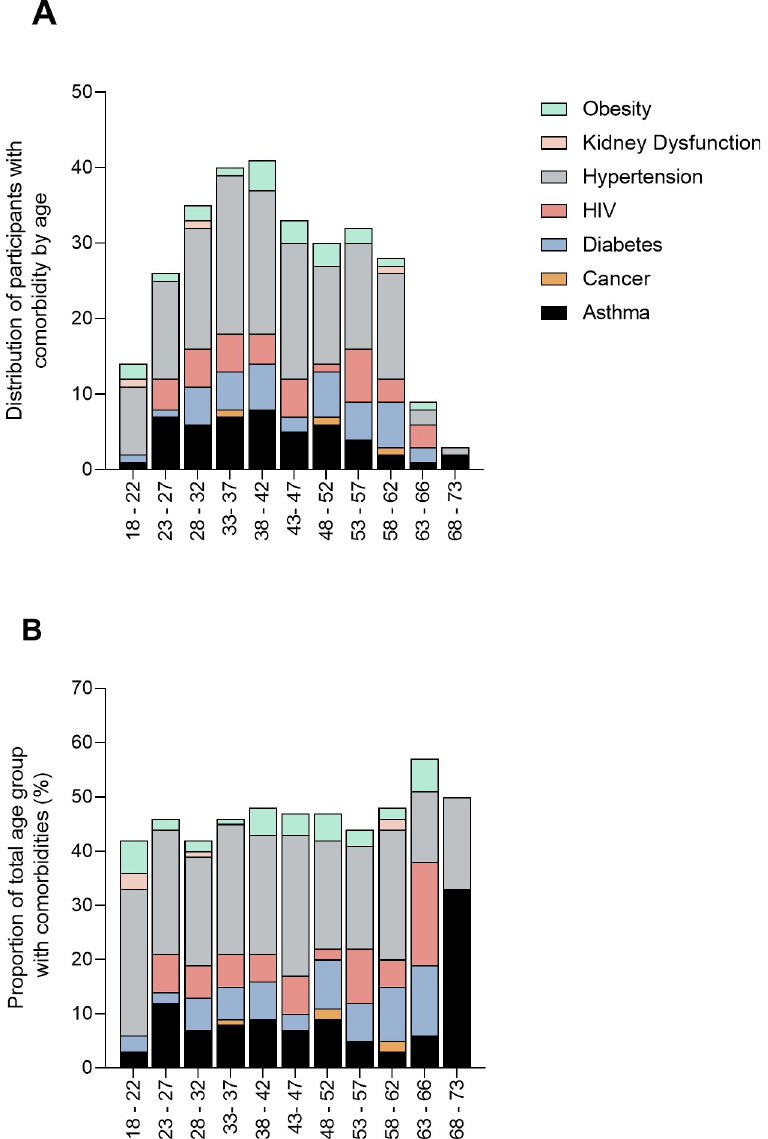
Fig 4. Distribution of the participants partitioned by age and reported co-morbidities as absolute numbers (A) and percentages (B). Of these seropositive people 15.8% (9 people) reported previous contact with a confirmed COVID-19 case. The distribution of the seropositive people by occupation, work station, age and self-reported comorbidities shown in Fig 5. The ward and OPD work stations had a great- est number of seropositive people. Odds ratios indicated that few factors were associated with sero-positivity (Fig 6) (data in Supplementary Tables, S2–S4 Tables). The odds ratios calcula- tions indicated that seropositivity was associated with working in OPD (OR 2.3, 95% CI = 1.23–4.28), aged 63–66 (OR 4.96, 95% CI = 1.66–14.81), years old and having kidney dys- function as a comorbidity (OR = 20.98, 95% CI = 1.87–235.1).The sample sizes of the different groups are given in Supplementary Tables, S5–S8 Tables. Analysis of the relationship between